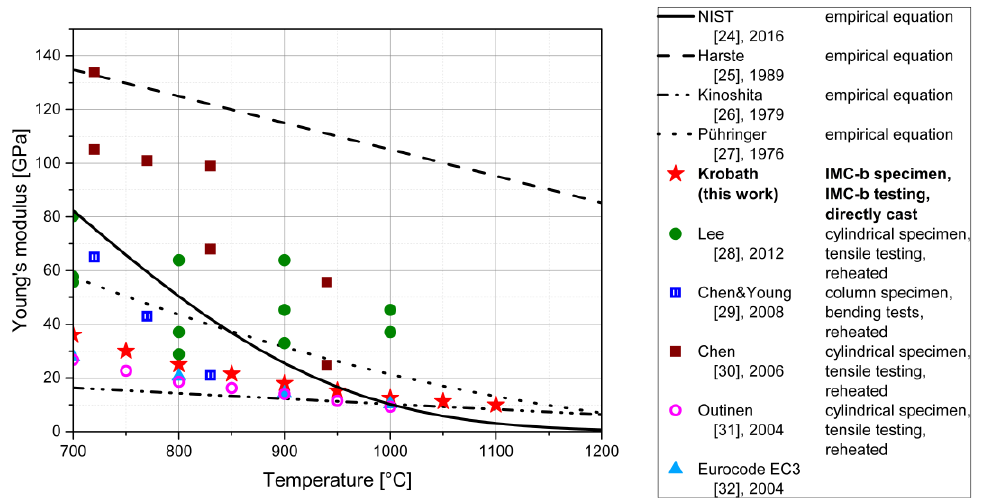
Figure 6. Compilation of a variety of documented Young’s moduli of structural steel at elevated temperatures from 700 to 1200 °C [24–32]. The dots represent experimental measurements, whereas the lines represent empirical equations. For experimental measurements, the specimen type, testing type, and microstructural history of the samples are described in the legend box.